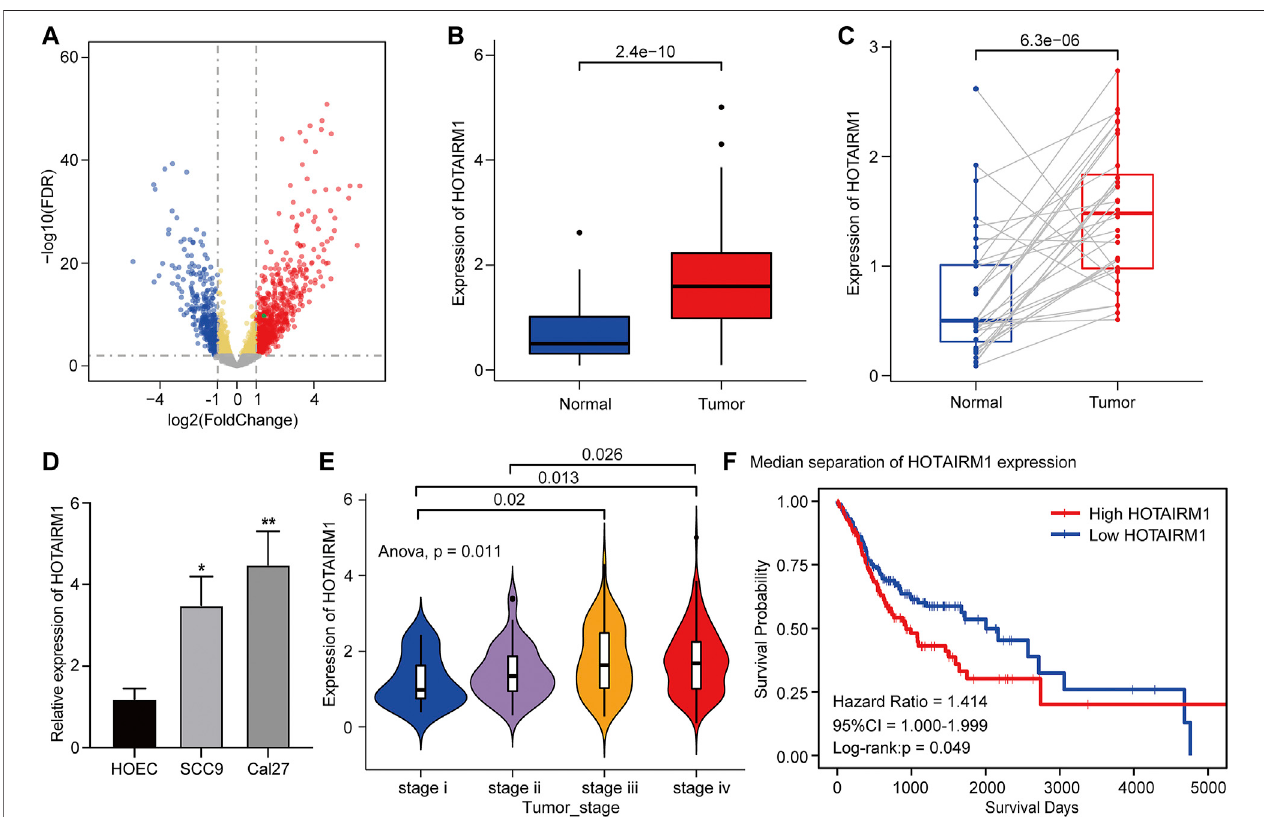
FIGURE2| Upregulationandclinicalsigni fi canceofHOTAIRM1inOSCC. (A) VolcanoplotforDEGs.Thebluerepresentedthesigni fi cantlydown-regulatedgenes; the red dots represented the signi fi cantly up-regulated genes; the green dot was the HOTAIRM1. (B) The comparison of HOTAIRM1 expression between all OSCC samplesandcontrolsamples. (C) ThecomparisonofHOTAIRM1expressionbetweenOSCCtissuesandcorrespondingadjacentnormaltissues. (D) qRT-PCRanalysis con fi rming HOTAIRM1 upregulation in OSCC cell lines. (E) Correlation analysis between HOTAIRM1 expression and OSCC tumor stage indicating the higher HOTAIRM1 expression was associated with a higher tumor stage. (F) Kaplan-Meier analysis suggested that high HOTAIRM1 expression was associated with unfavorable prognosis in OSCC. * p < 0.05, ** p < 0.01.